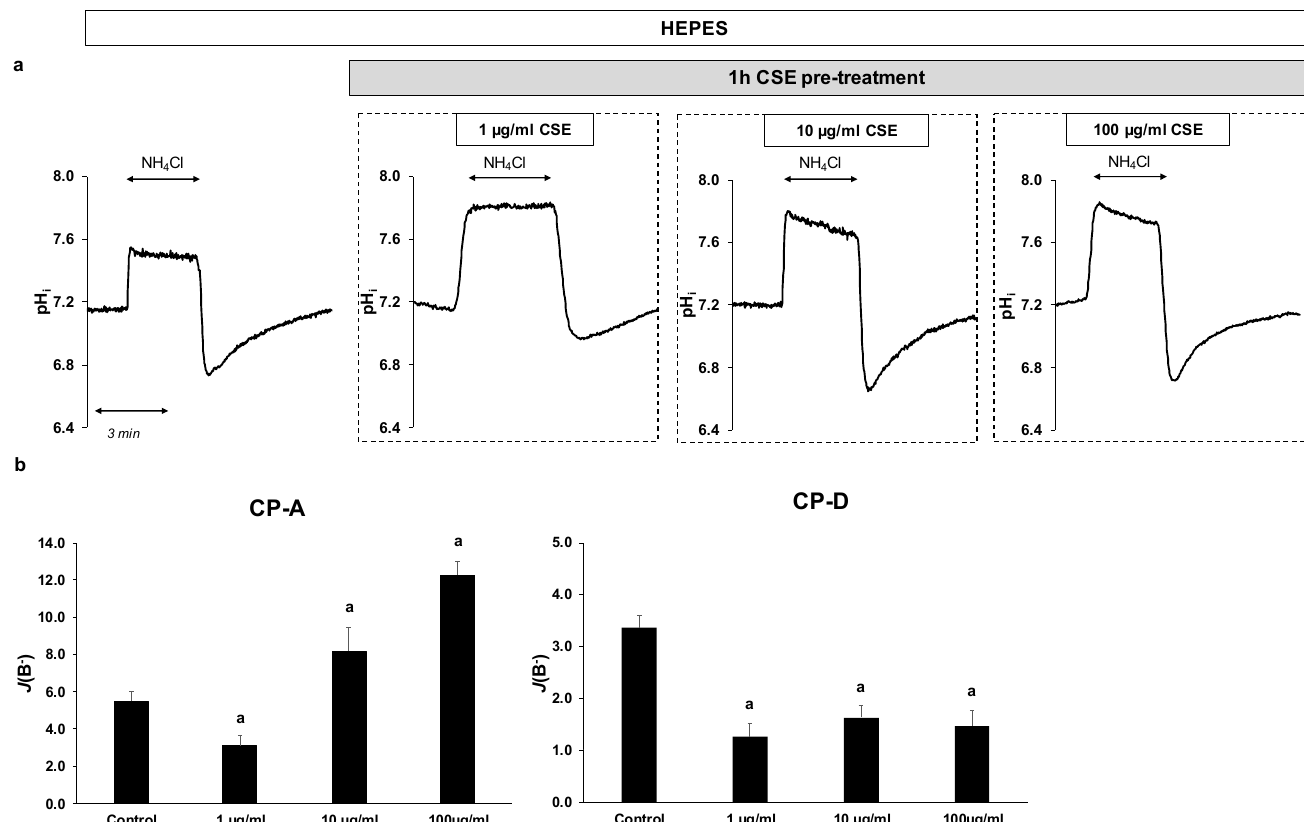
Figure 3. Effects of cigarette smoke extract (CSE) treatment on the activity of Na + /H + exchanger-1 (NHE-1) in esophageal cell lines. Metaplastic (CP-A) and dysplastic (CP-D) esophageal cell lines were pretreated with different concentrations of CSE (1, 10 and 100 µg/mL) for 1 h, and the activity of NHE-1 was measured. ( a ) Representative intracellular pH (pH i ) curves present the recovery from acidosis in CP-A cells. ( b ) Summary data of the calculated activity of NHE-1 in the different cell lines. The rate of pH recovery ( J (B − )) was calculated as described in Figure 2b. Data are presented as the mean ± SEM; a = p ≤ 0.05 vs. control; n = 12–14 exp./66–68 ROIs.